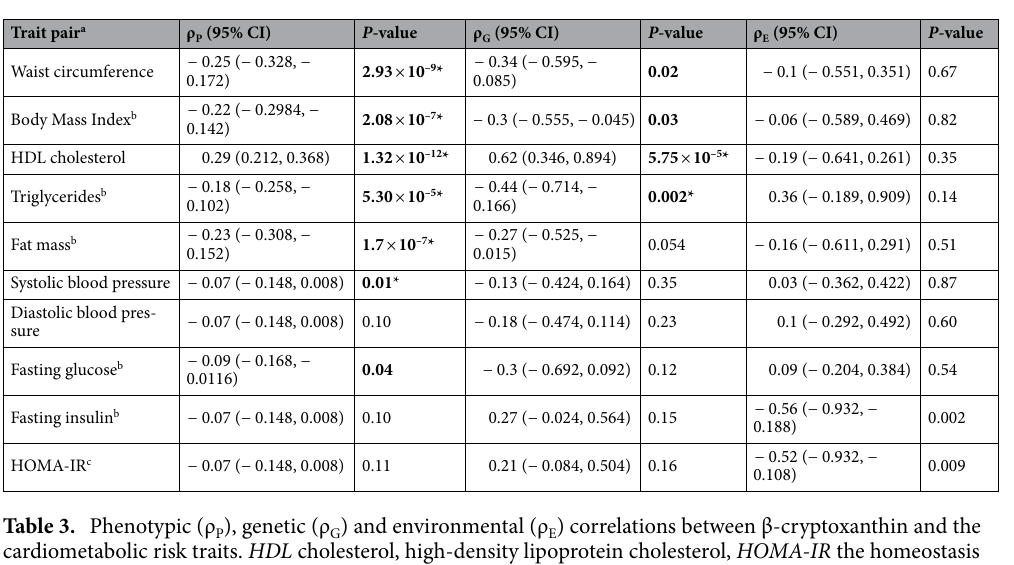
β-carotenoids. PMI values between 2 and 4 showed the maximum variability associated with carotenoids.